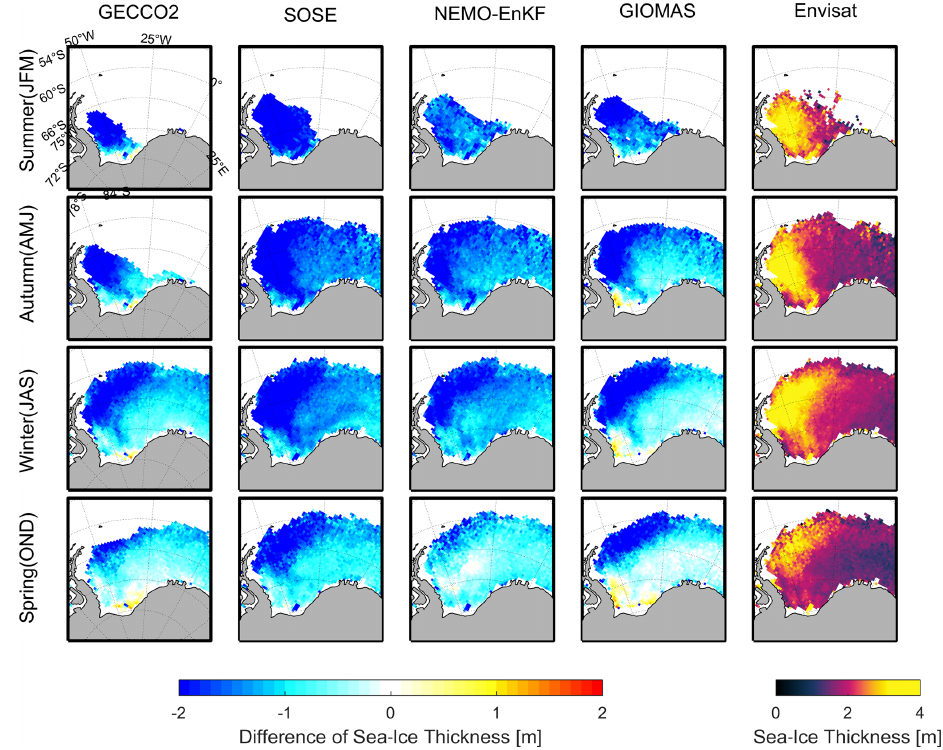
Figure 7. Same as Fig. 6 but with respect to Envisat (last column) for the 4 year period 2005–2008.